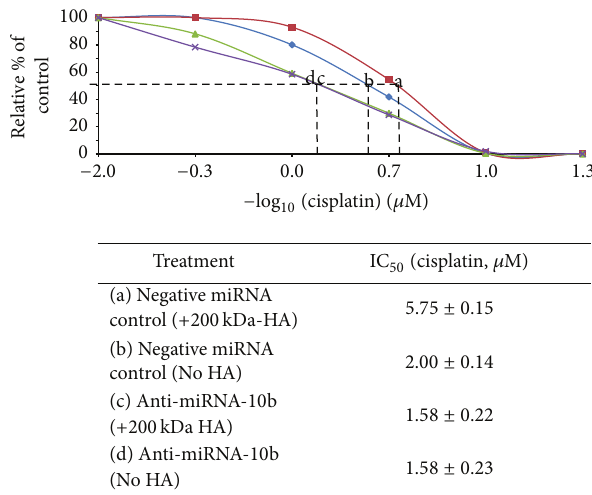
Table 2: Effects of anti-miR-10b on cisplatin-induced cell growth inhibition in CD44v3 high ALDH1 high cells following 200 kDa-HA treatment. Treatments Cisplatin-induced tumor cell growth inhibition IC Negative miRNA control-treated cells (control) (No HA) 2.00 ± 0.15 (100.00%) Negative miRNA control-treated cells (+200kDa-HA) 5.75 ± 0.14 (288.00%) Anti-miR-10-treated cells (No HA) 1.58 ± 0.22 (0.79%) Anti-miR-10b-treated cells (+200kDa-HA) 1.58 ± 0.23 (0.79%)